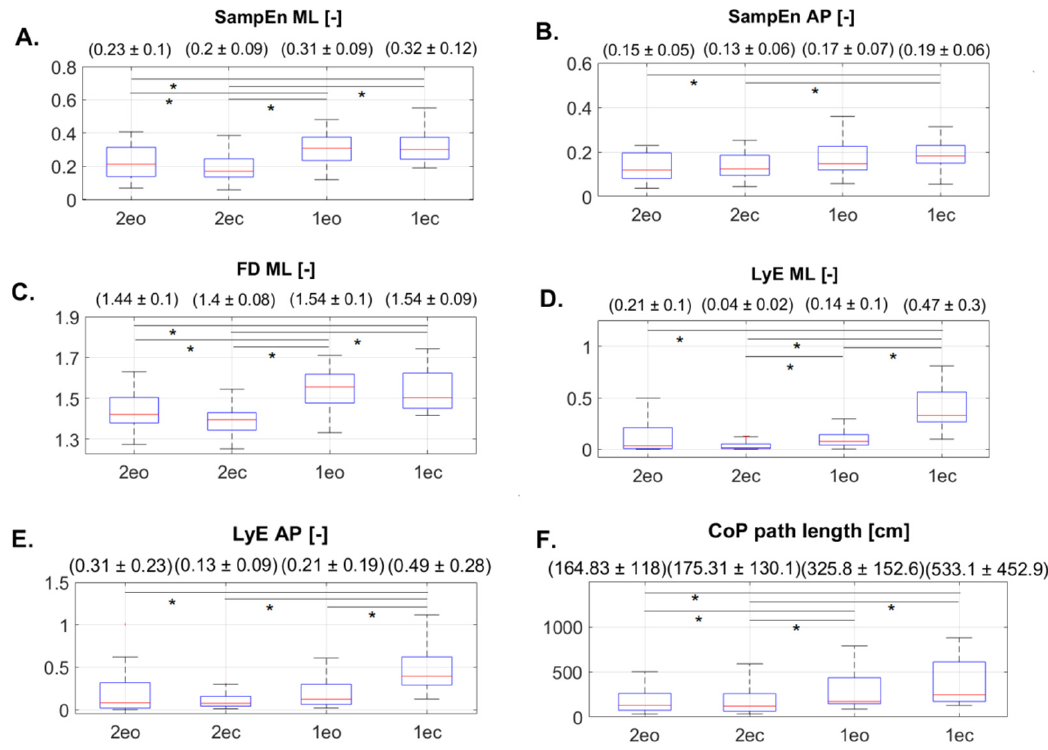
Figure 2. Whiskers and box plots of nonlinear and linear parameters for each test (2eo, 2ec, 1eo, 1ec); where eo—eyes open; ec—eyes closed; 2—both leg standing; 1—one leg standing. ( A ). Sample entropy calculated in mediolateral direction; ( B ). sample entropy calculated in anterior–posterior direction; ( C ). fractal dimension calculated in mediolateral direction; ( D ). Lyapunov exponent calculated in mediolateral direction; ( E ). Lyapunov exponent calculated in anterior–posterior direction; ( F ). center of pressure path length. The central mark indicates the median, and the bottom and top edges of the box indicate the 25th and 75th percentiles, respectively. Mean values and standard deviations are in parentheses. The whiskers extend to the most extreme data points; * marks statistically significant differences between factors ( p ≤ 0.05).